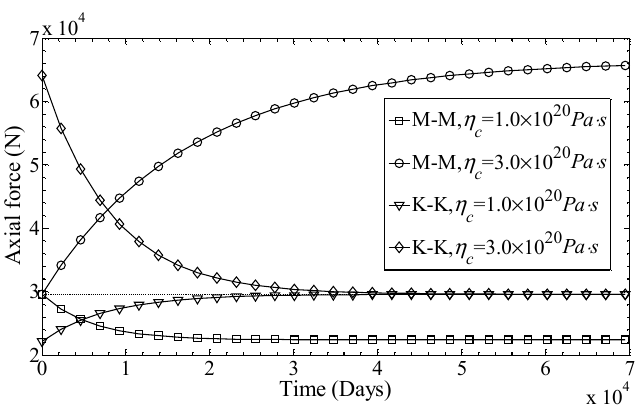
Figure 6. Axial force–time curves obtained from M–M model and K–K model with different viscosity coefficients of rockbolts.